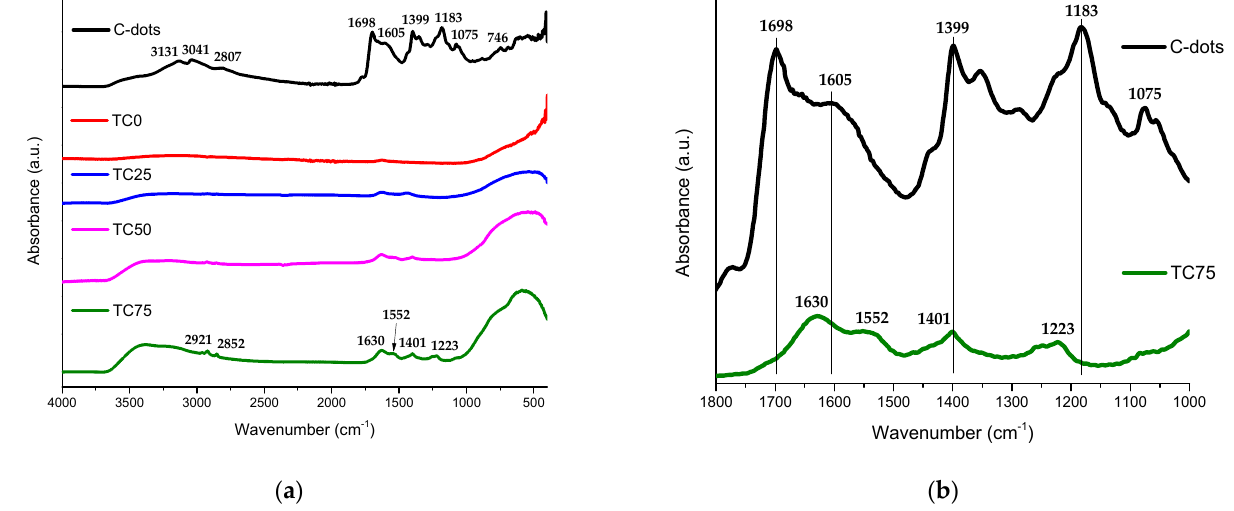
Figure 6. FTIR spectra of ( a ) C-dots, TC0, TC25, TC50 and TC75 photocatalysts and ( b ) the zoom area (1800–1000 cm − 1 ) of C-dots and TC75 photocatalyst.